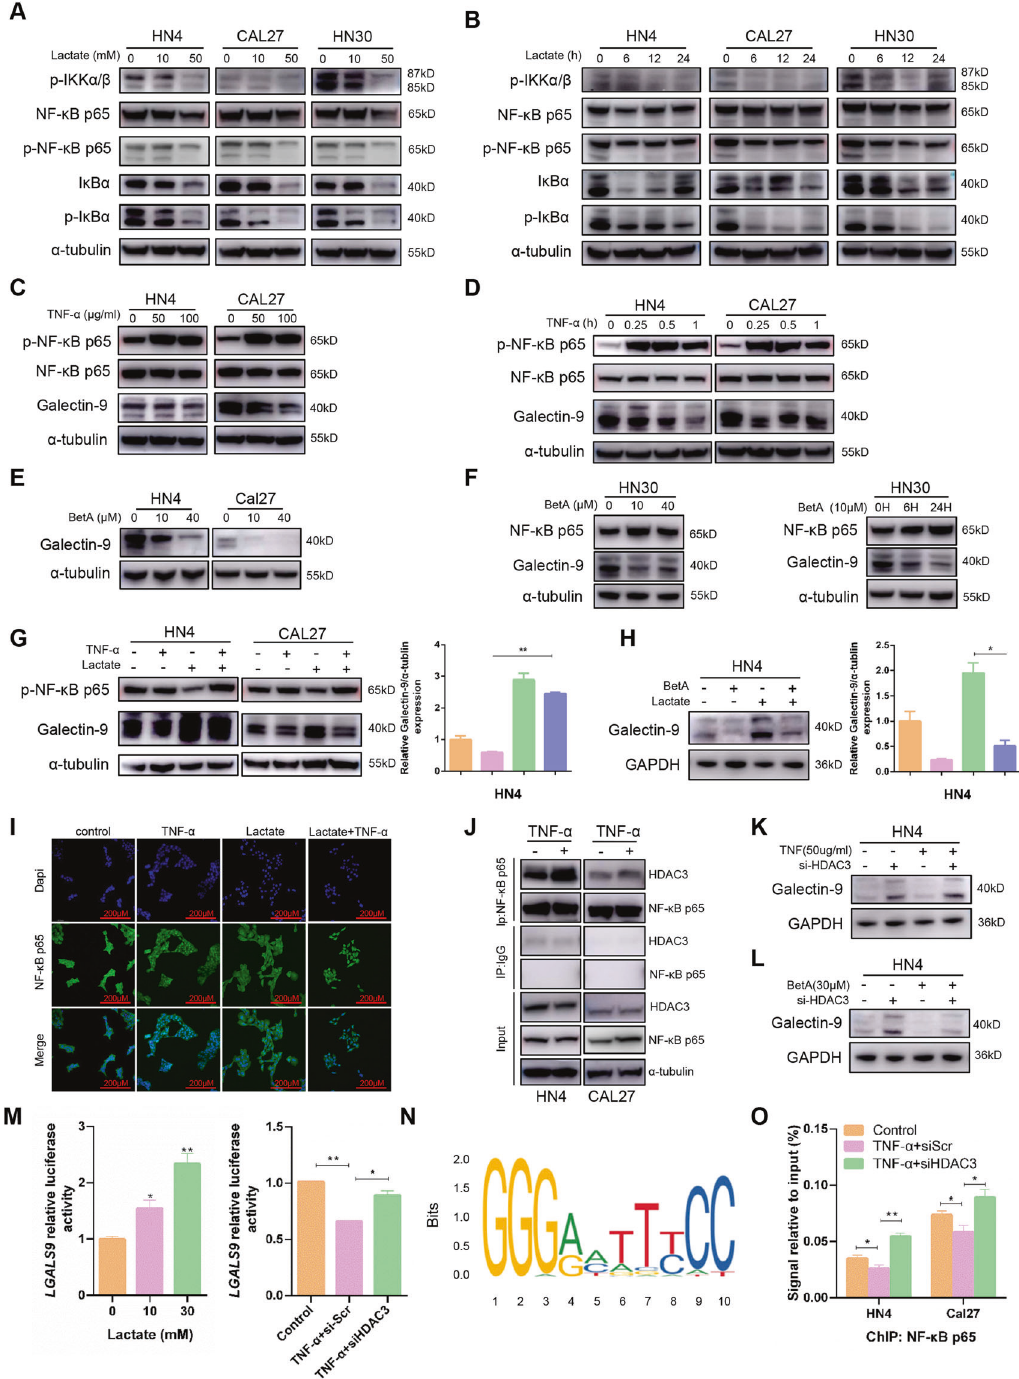
Fig. 6 Lactate-induced Galectin-9 expression through inhibition of NF- κ B signaling. A , B p-IKK α / β , NF- κ B p65, and I κ B α expression were detected after lactate stimulation in HNSCC cells for 24 h or 10 mM. The protein levels of Galectin-9 was detected after treatment of HN4 and Cal27 cells with TNF- α for 1 h ( C ) or 50 μ g/ml ( D ). E After treatment with BetA, Galectin-9 was assessed using western blot. F The protein levels of NF- κ B p65 and Galectin-9 were detected after treatment of HN30 cells with BetA. G After treatment with 50 μ g/ml TNF- α and 10 mM lactate in HN4 and Cal27 cells, NF- κ B p65 and Galectin-9 was assessed using western blot. H The expression of NF- κ B p65 and Galectin-9 was determined in HN4 cells after incubation with 10 μ M BetA and 10 mM lactate. I An immuno fl uorescence assay was used to visualize the localization of NF- κ B p65 after treatment with 50 μ g/ml TNF- α and 10 mM lactate. J Immunoprecipitation assay was performed using anti-NF- κ B p65 antibody or IgG in HN4 and Cal27 cells after treatment with 50 μ g/ml TNF- α . After HDAC3-speci fi c siRNA transfection for 24 h, HN4 cells were treated with 50 μ g/ml TNF- α for 15 min ( K ) or 10 μ M BetA ( L ) for 24 h and then Galectin-9 was analyzed. M Transcriptional activity was detected using dual-luciferase reporter assays with LGALS9 promoter-luciferase plasmids after treatment with 10 mM lactate or 10 μ M BetA and HDAC3-speci fi c siRNA in 293T cells. N The binding sites of NF- κ B p65 in the Galectin-9 promoter was predicted according to JASPAR database. o ChIP assays were performed after treatment with 50 μ g/ml TNF- α and HDAC3-speci fi c siRNA. * P < 0.05, ** P <